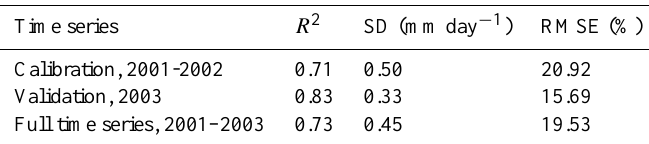
Table 3. Model calibration and validation results reported as the coefficient of determination ( R 2 ), standard deviation of differences (SD), and root mean square errors (RMSEs) for 16-day averages.